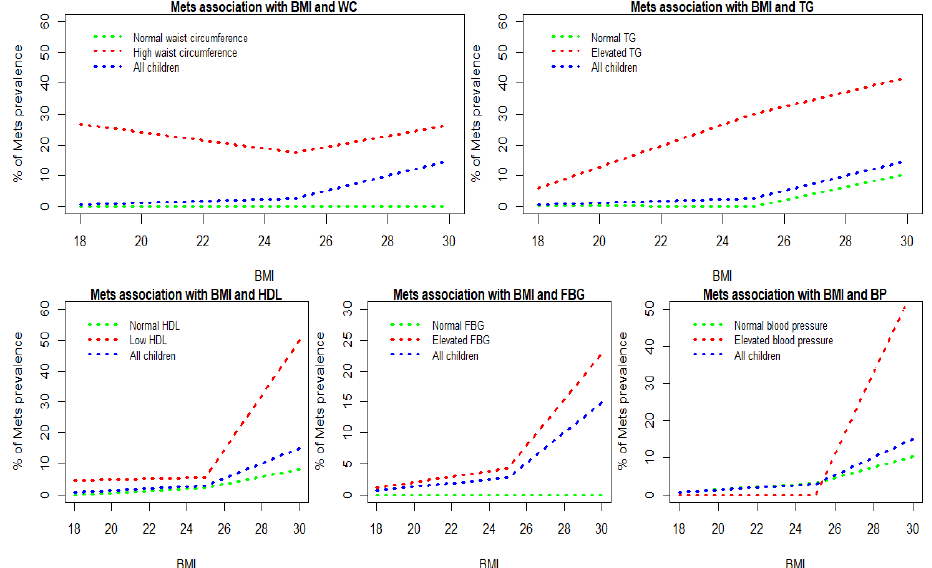
Figure 1. Comparison between metabolic components and BMI among Sudanese early adolescences. Abbreviations: WC—Waist Circumference; BP—Blood Pressure; FBG—Fasting Blood Glucose; TG—Triglycerides; HDL—High ‐ Density Lipoprotein. Table 1. General background characteristics of the participants based on gender.